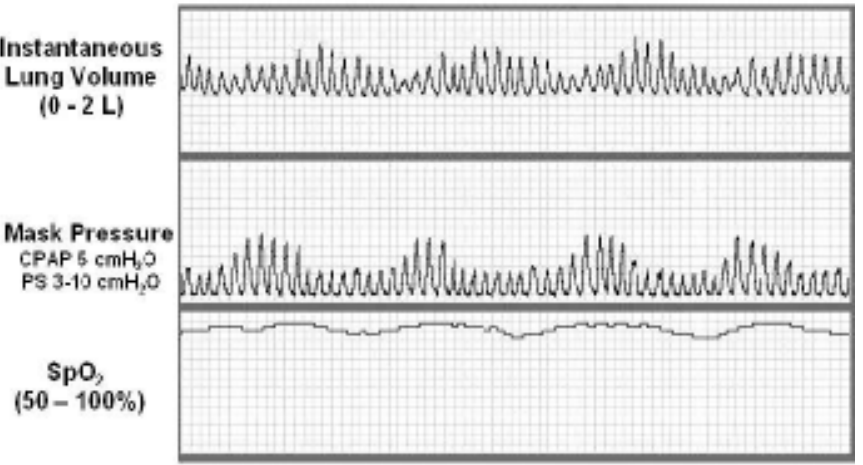
Tracing of 4 min of adaptive servoventi- lation (ASV) in a pa- tient with Cheyne- Stokes respiration. The top panel depicts the tidal breathing measured by an in- ductance plethysmo- graph. The mid-panel shows the mask pres- sure applied during adaptive servoventi- lation. Pressure sup- port (PS) is maximal (10 cmH 2 O) during hypopnoea and mini- mal (3 cmH 2 O) dur- ing hyperpnoea, while end-expiratory pressure (CPAP) re- mains constant at 5 cmH 2 O. Anticyclically supported ventilation smooths the oscilla- tory breathing pat- tern and the subse- quent oscillations in oxygen saturation (SpO 2